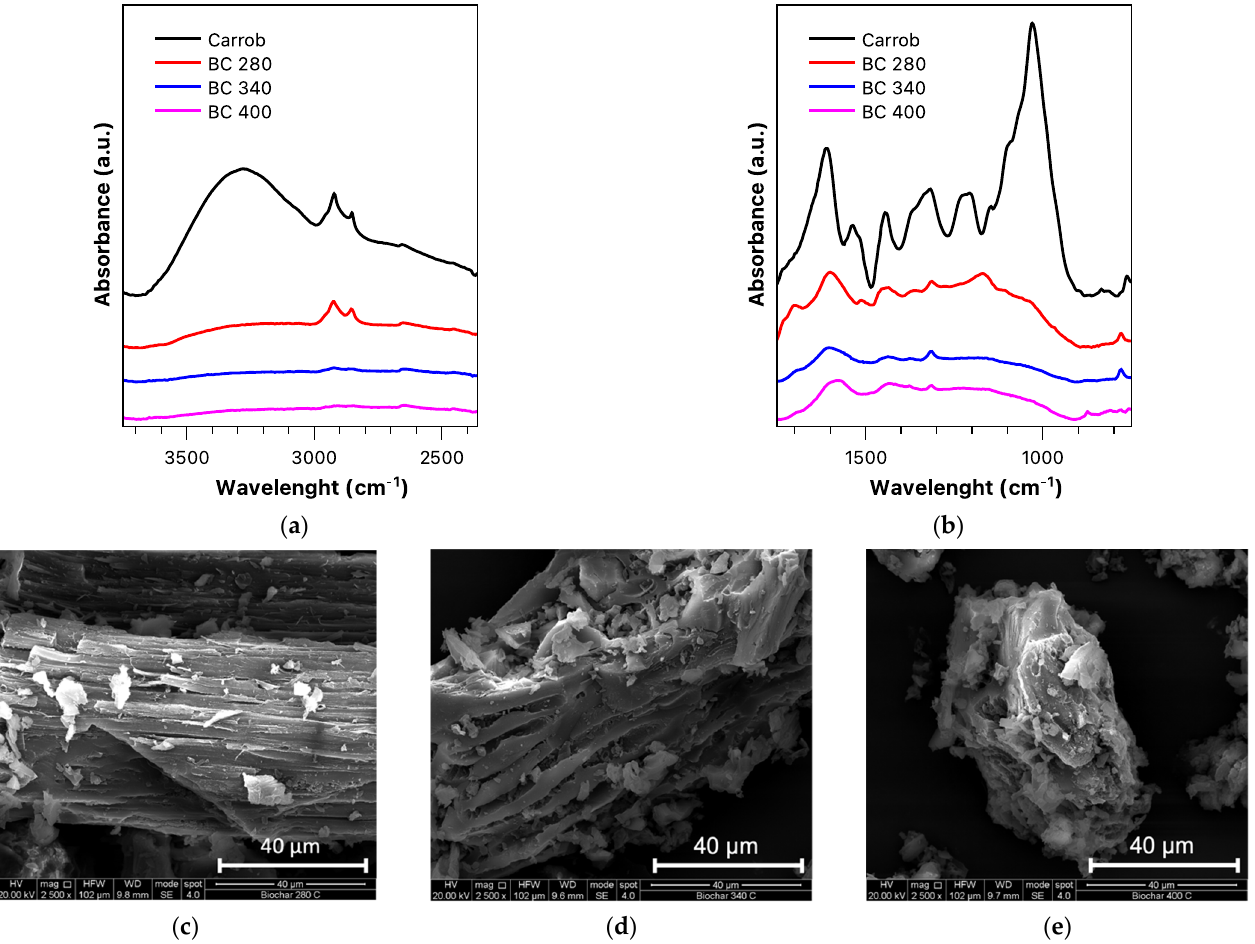
Figure 2. ( a ) 3750–2360 cm − 1 ( b ) 1750–750 cm − 1 ATR-FTIR spectra (a.u.) of carob waste after syrup extraction and produced biochar particles after slow pyrolysis at different temperatures, and SEM images of BCP obtained pyrolyzing carob waste at ( c ) 280 ( d ) 340 and ( e ) 400 °C.